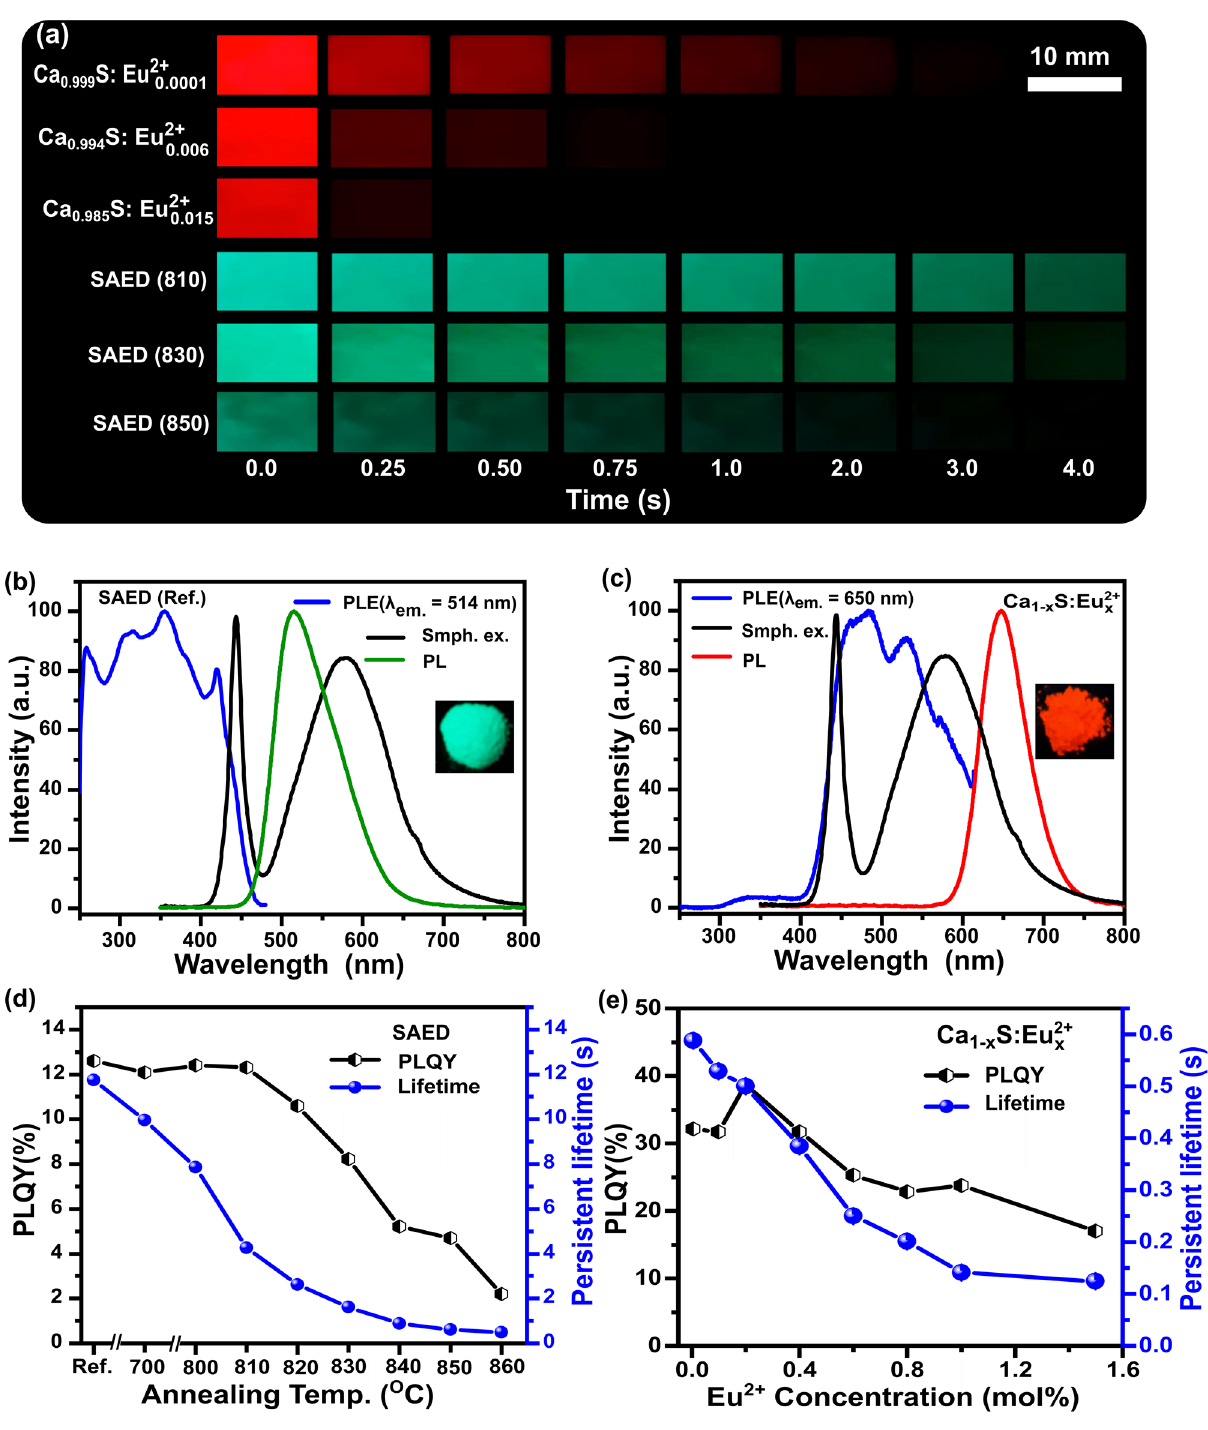
Figure 2. Photoluminescence (PL) properties of the persistent phosphors. (a) Video still frames at indicated 2 + Ca 0.994 S:Eu 2 + times after smartphone video excitation is stopped for red phosphors ( Ca 0.999 S:Eu 0.001 , 0.006 and Ca 0.985 S:Eu 2 + 0.015 ) and green phosphors (SAED (810), SAED (830) and SAED (850)) visually demonstrating the change in persistent lifetime. (b) The PL excitation spectrum (monitored at 514 nm) of SAED (Ref.) alongside the emission spectrum of a smartphone-flashlight (Smph.ex.) (Black line) and the PL emission spectra after smartphone excitation. The small overlap of the smartphone excitation with the absorption is just sufficient to allow smartphone excitation. (c) The PL excitation spectrum (monitored at 640 nm) of CaS:Eu 2+ alongside its PL emission spectrum and that of a smartphone-flashlight. The substantial overlap in the phosphor absorption and smartphone-flashlight means that it is efficiently excited. The insets in (b,c) show the phosphor emissions after the smartphone excitation. (d) The steady state PL quantum yield (PLQY) following 450 nm excitation and persistent lifetime values of SAED samples that are annealed in air for 1 h. (e) The steady state PLQY and 2 + persistent lifetime values of Ca 1 − x S:Eu x samples for 0.0005 ≤ x ≤ 0.015 mol after 450 nm LED